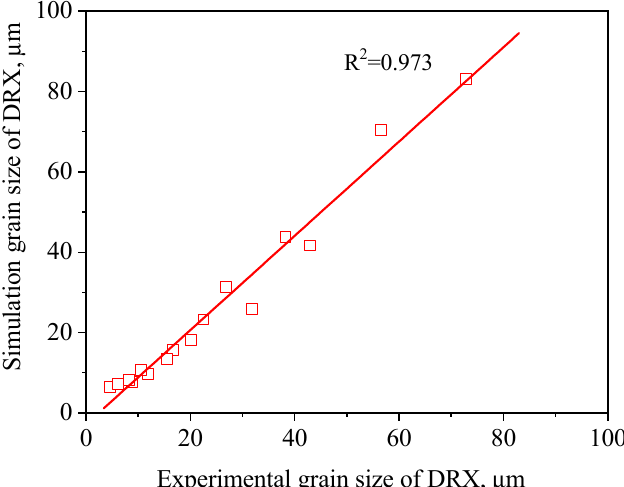
Figure 19. Correlation between the simulation and experimental d DRX for TB8 titanium alloys after hot deformation.